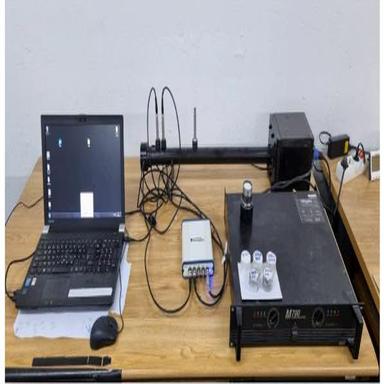
Ø38 mm impedance tube and equipment used to determine acoustic absorption.